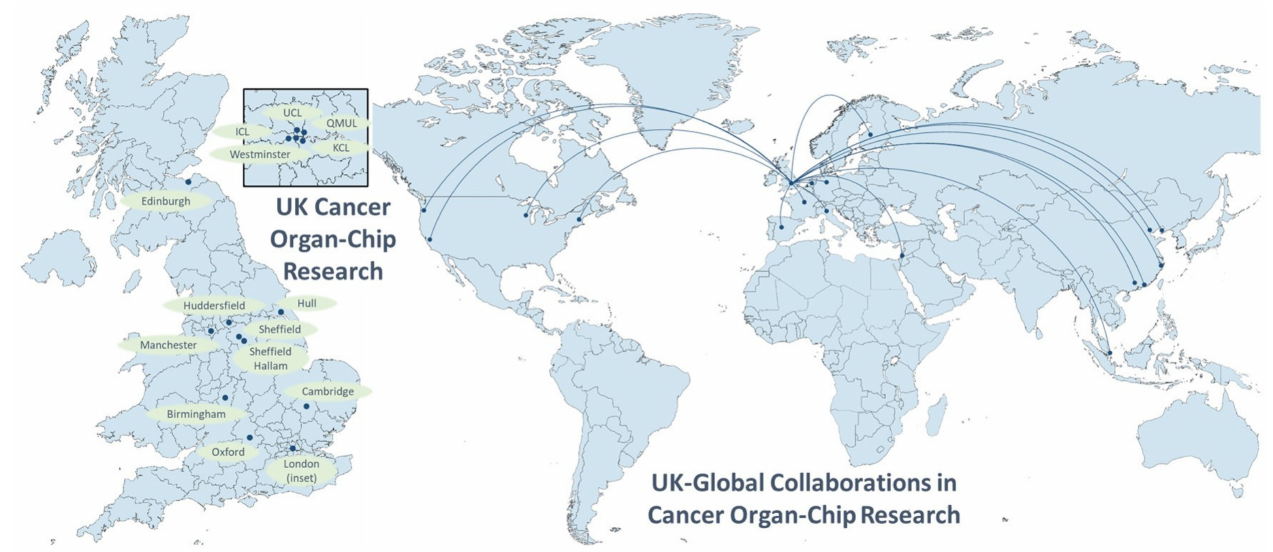
Figure 1. UK cancer research centres building organ-chip models, and worldwide UK collaborations in the field. Global collaborators include institutions in China (Beijing, Dalian, Guangzhou, Hong Kong, Zhejiang), Europe (Finland, France, Germany, Italy, the Netherlands, Spain) and the United States (California, Massachusetts, Washington, Wisconsin).